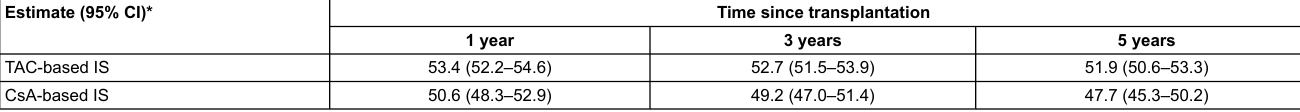
Table 4: Mean estimated glomerular filtration rate according to immunosuppressive therapy at different time points post-transplantation . Estimate (95%